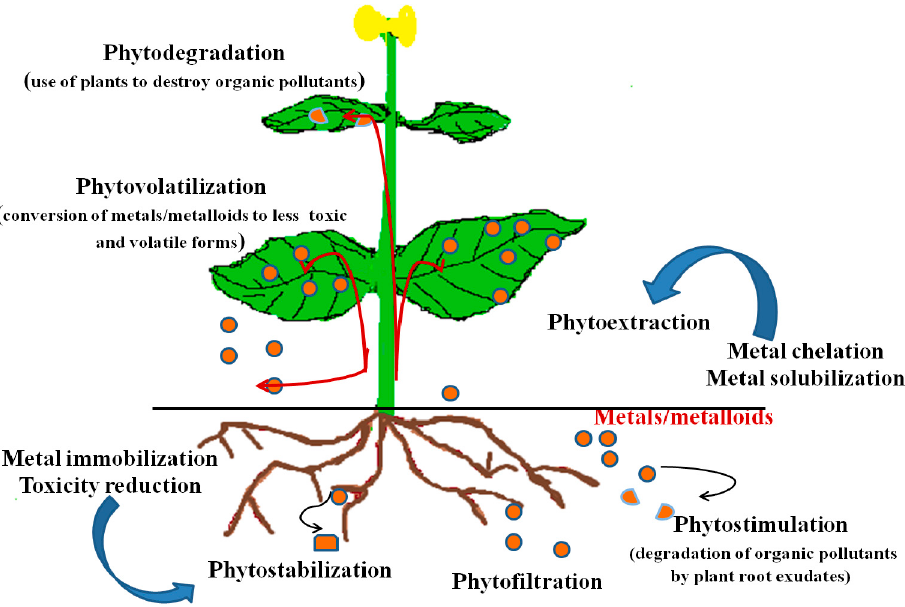
Figure 3. Processes used in phytoremediation of heavy metals. Figure designed not cited.